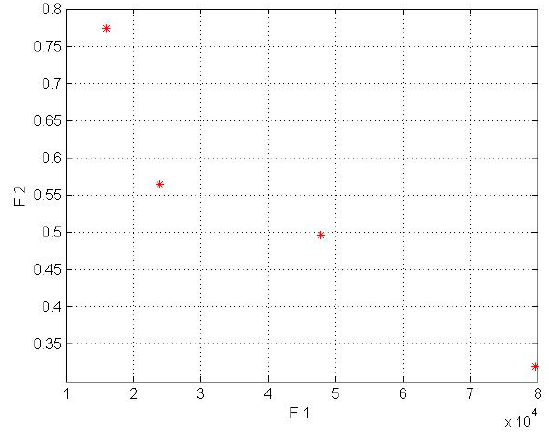
Figure 4. Pareto front results for a wind turbine without a lens in Kish Island (* shows COE by AEP). The obtained answers complied with our goal to maximize the AEP and to minimize the Table 6. The Pareto front result for a wind turbine without a lens.